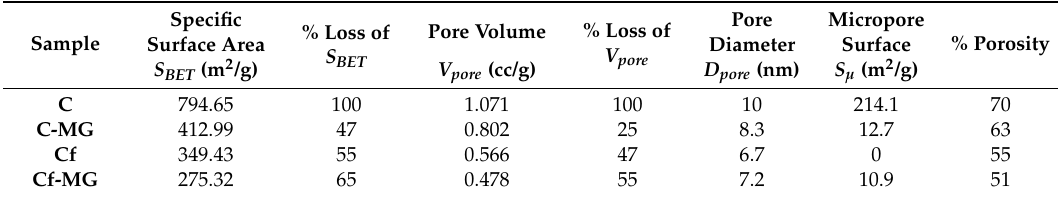
Table 1. Textural properties of the prepared silica-based